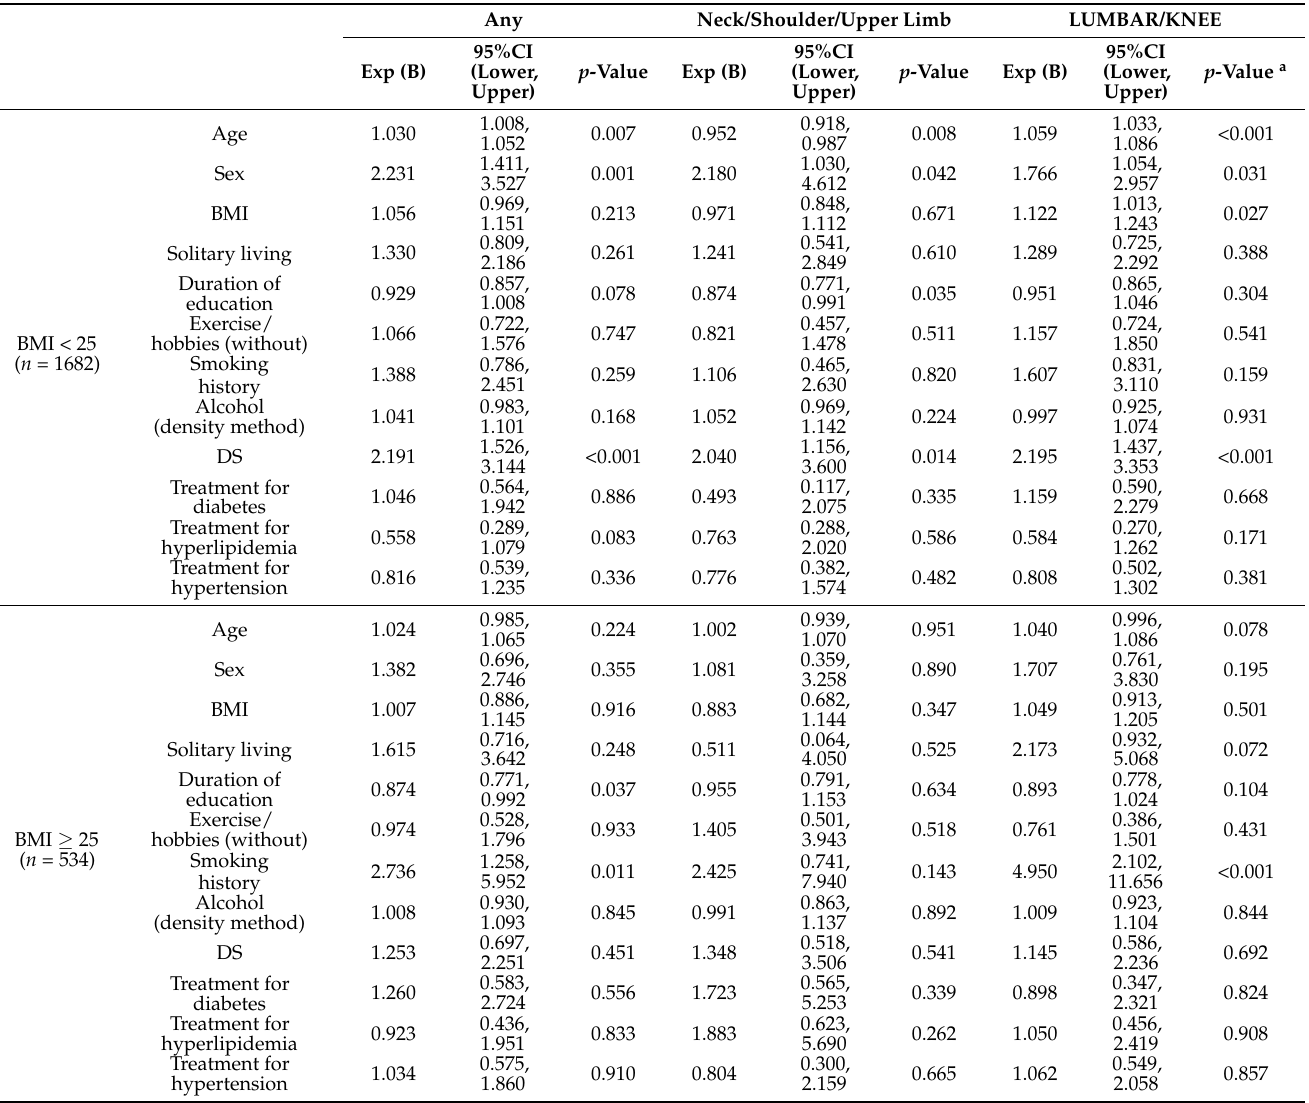
Table 5. Relationship between CP location and DS stratified by